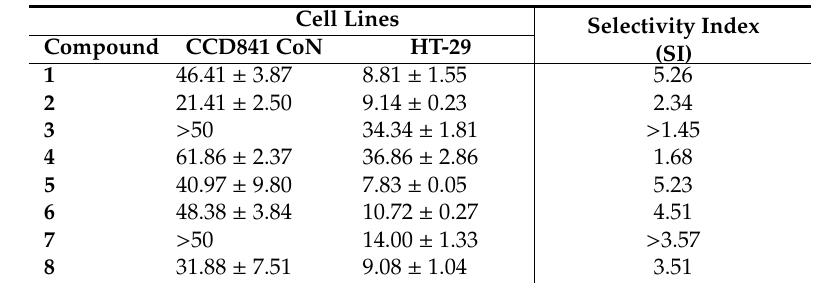
Table 1. IC 50 values ( µ g / mL) obtained for meroterpenes (AMTs) 1 - 8 against the colon cancer cells HT-29 and the normal colon cells CCD 841 CoN after 72h of treatment (data are means ± SE of three experiments). SI = IC 50 value for normal cells / IC 50 value for cancer